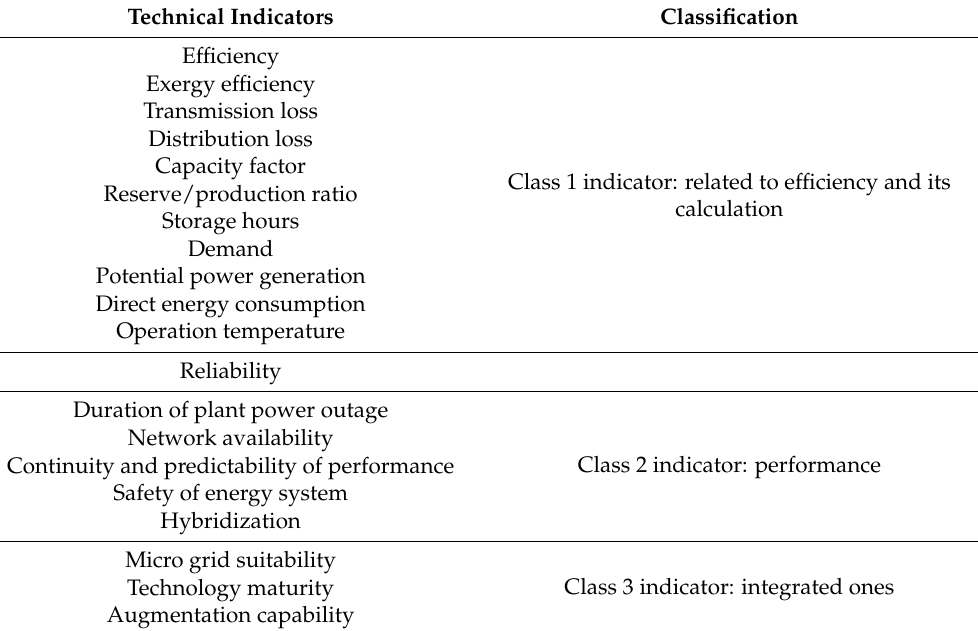
Table 5. The most commonly utilized technical